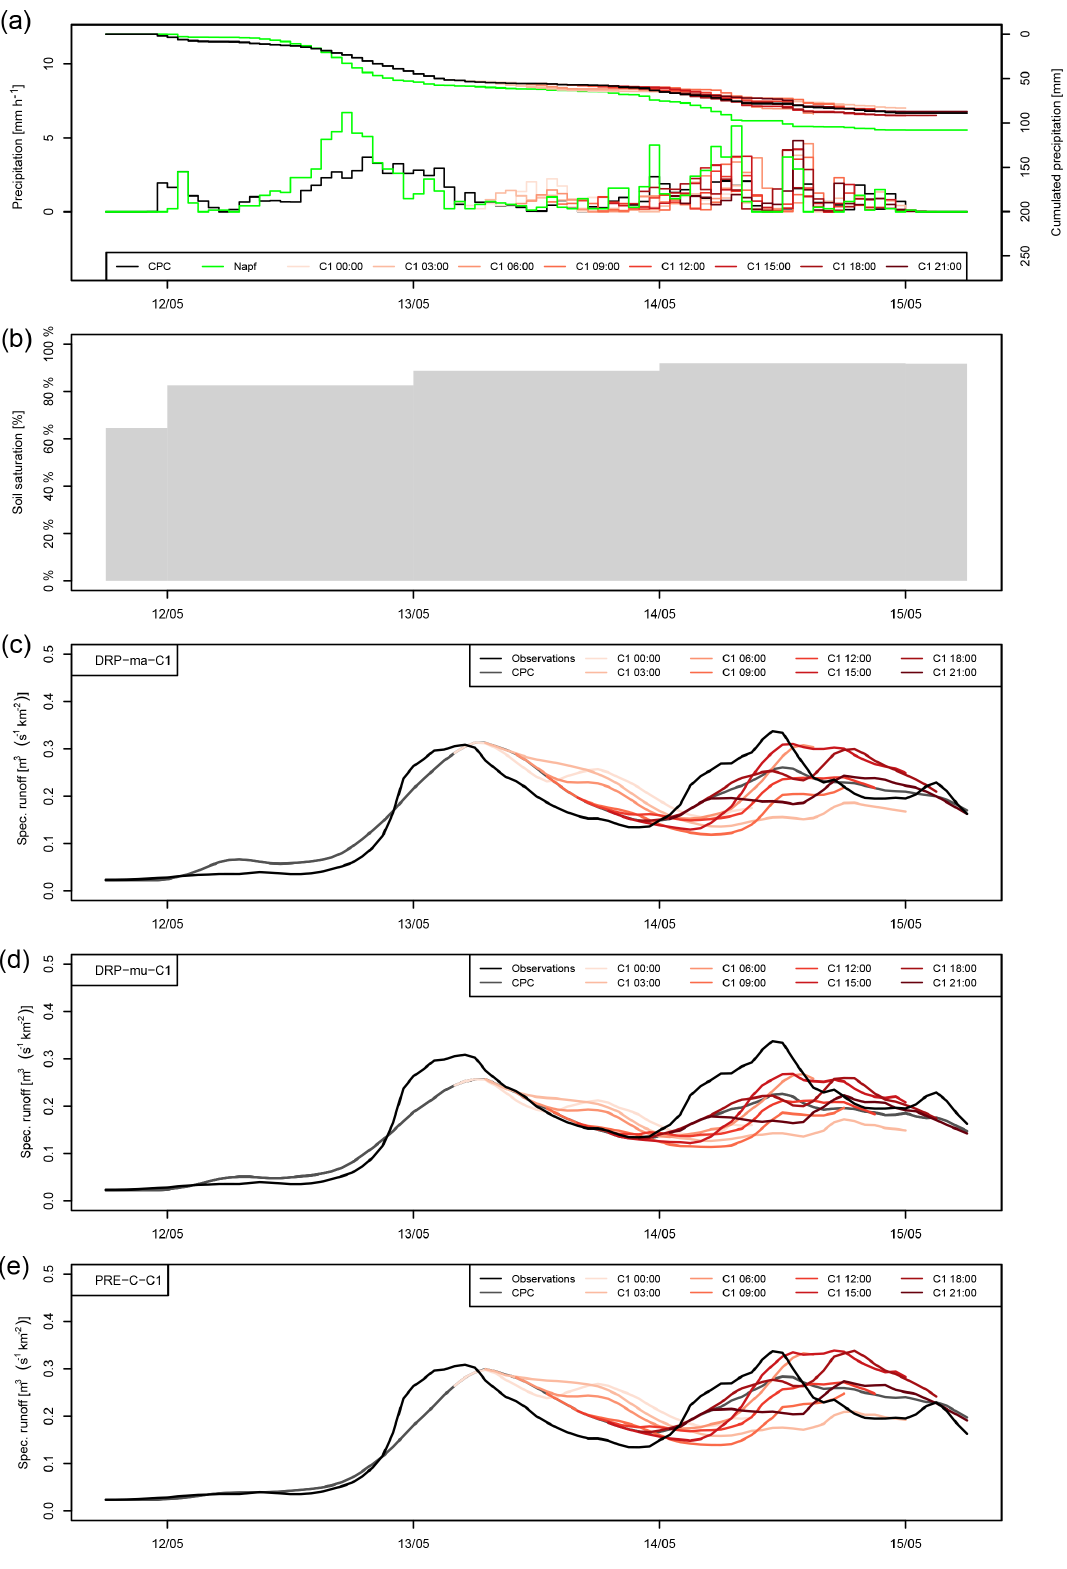
Figure 5. Flood predictions with (c) DRP-ma-C1, (d) DRP-mu-C1 and (e) PRE-C-C1 for Emmenmatt with eight initialisations each on the alert date of 13 May 2016. Catchment precipitation predictions from COSMO-1 and measurements from the Napf station and CombiPrecip (both provided by MeteoSwiss) are depicted in (a ), and evolution of soil moisture from PREVAH simulations is depicted in (b)